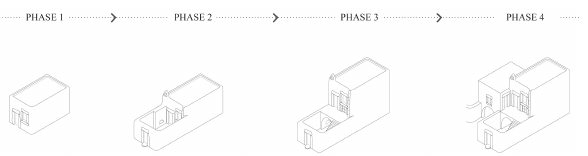
Figure 5. Phases of dwellings’ development.